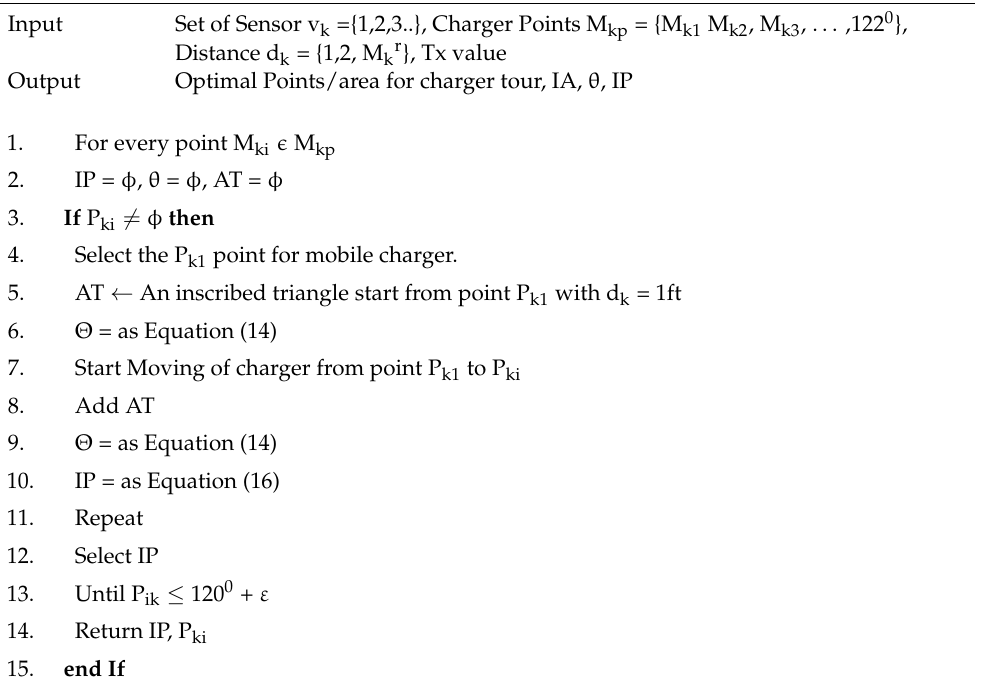
Algorithm 2 : Charger Placement Strategy for Patch